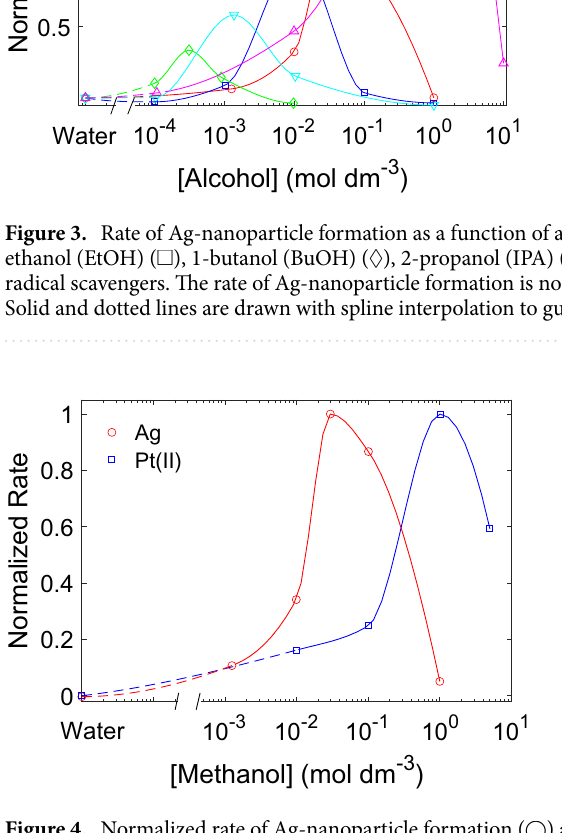
Figure 4. Normalized rate of Ag-nanoparticle formation ( (cid:31) ) and Pt(II) formation ( (cid:31) ) as a function of methanol concentration. Solid and dotted lines are drawn with spline interpolation to guide the eye.